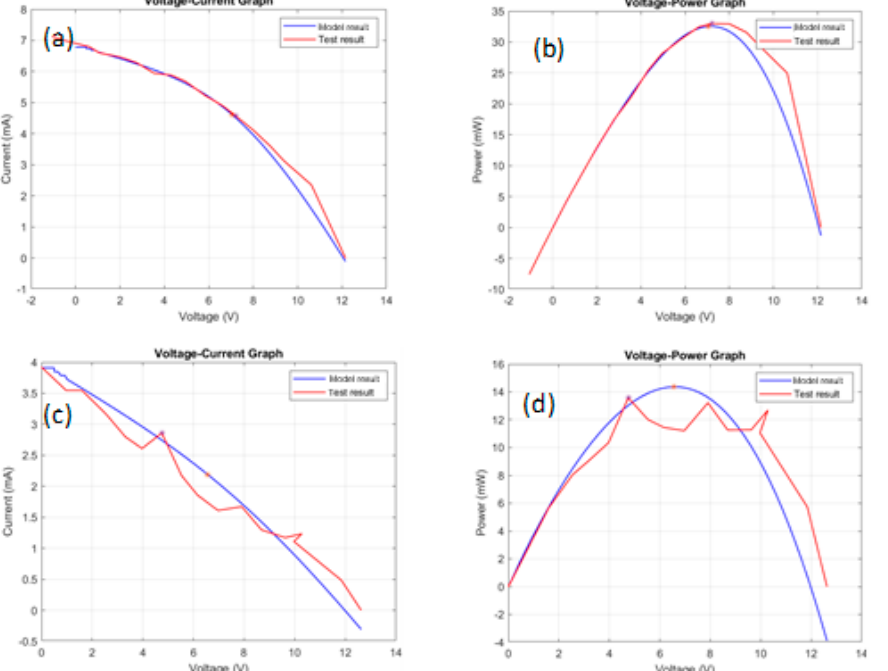
Figure 8. ( a ) I-V curve and ( b ) P-V curve comparisons of 360 cm 2 module tested on 28 August 2018; ( c ) I-V curve and ( d ) P-V curve comparisons of 360 cm 2 module tested on 8 November 2018. The maximum power point in each I-V/P-V waveform is highlighted as red or purple point, respectively. The open circuit voltage decreases from approximately 300 V to 140 V and 12 V with smaller module sizes (from 5904 cm 2 to 2928 cm 2 and 360 cm 2 ), as shown in Figures 6–8. The simulated results match the measurements quite well for all three modules in August, but the difference between experimental results and model are evident for the October and November dataset. In Figure 6, the maximum power error between simulation and test results is 2.66% on 24 August but increases to 7.93% on 29 October (5904 cm 2 module); in Figure 7, the error increases from 0.22% to 18.57% from 3 August to 29 October (2928 cm 2 module); in Figure 8, the errors are 1.36% on 28 August and 5.80% on 8 November (360 cm 2 module). All measurement result curves show oscillations for data collected in October or November, which means the modules degraded. However, the 5904 cm 2 mod- ule I-V and P-V curves are still quite stable when compared to the other two modules, hence it is the least affected. Figure 9 compares the maximum power errors between simulation results and meas- urements. It is evident that the error between simulation/experimental of the three mod- ules are all below 10% in August, but the 2928 cm 2 and 360 cm 2 module errors increase sharply from late October. The figure also shows that the 5904 cm 2 error fluctuates the least while the 360 cm 2 fluctuates the most, which means a larger sized module can gen- erate more stable results.